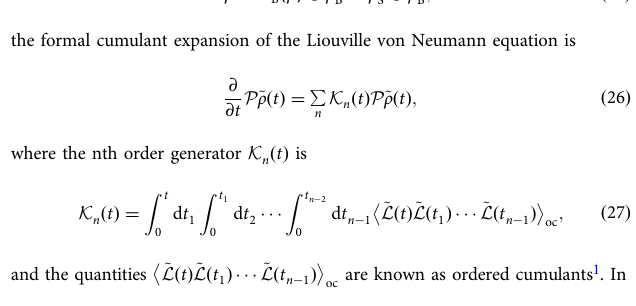
perature T = 12.5mK. We performed numerical simulations with different models of B P :